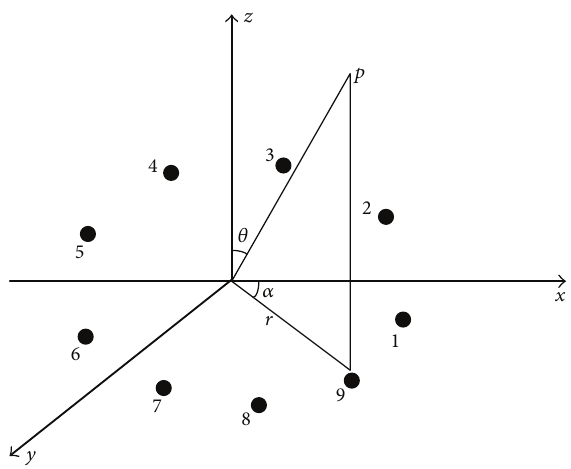
Figure 1: The structure of a nine-element circular ultrasonic